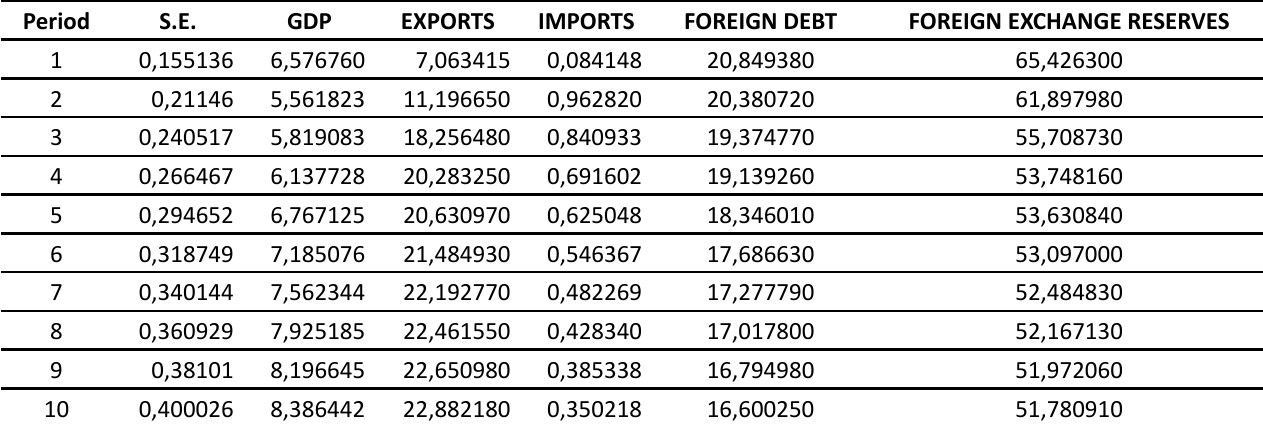
Table 8: VD Test of Foreign Exchange